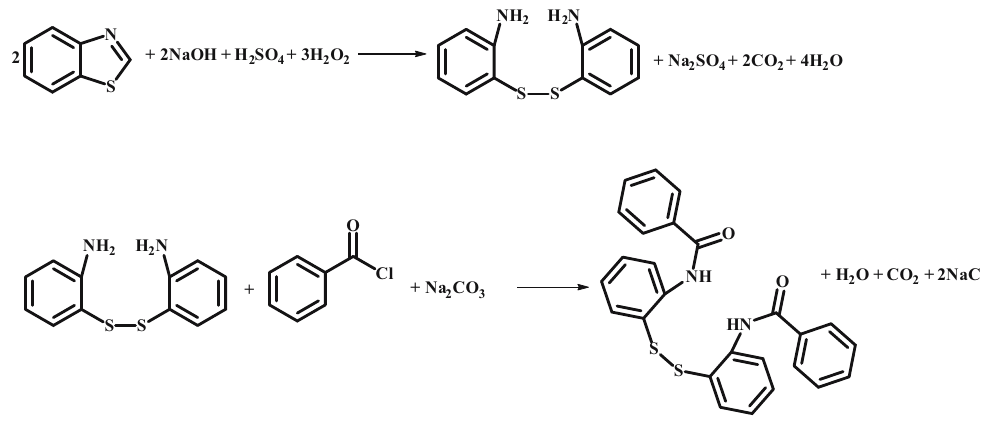
Figure 4: The main reaction equation in the DBD production